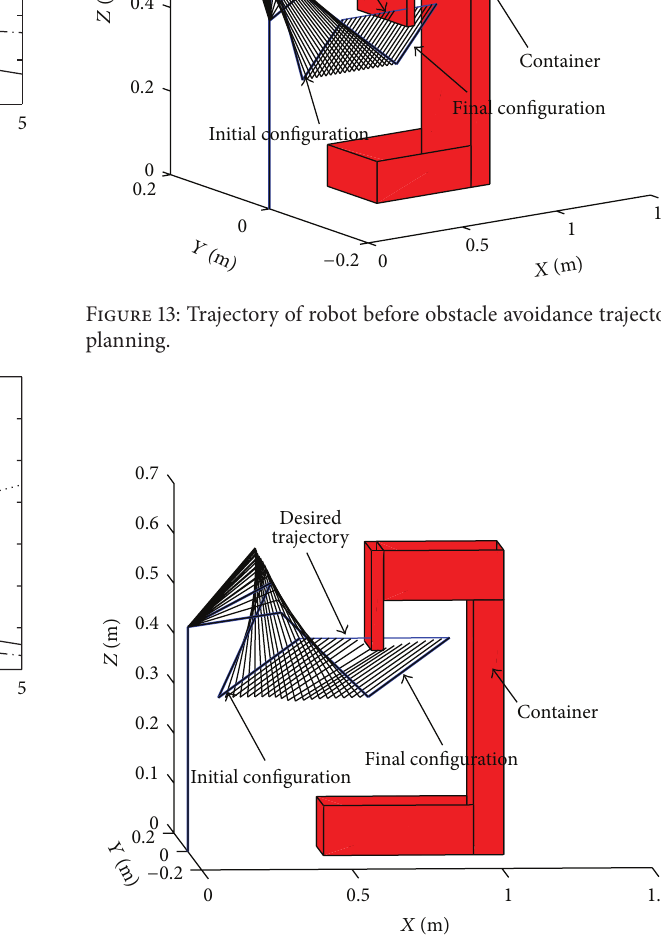
Figure 14: Trajectory for obstacle avoidance using the approach based on transitioning between